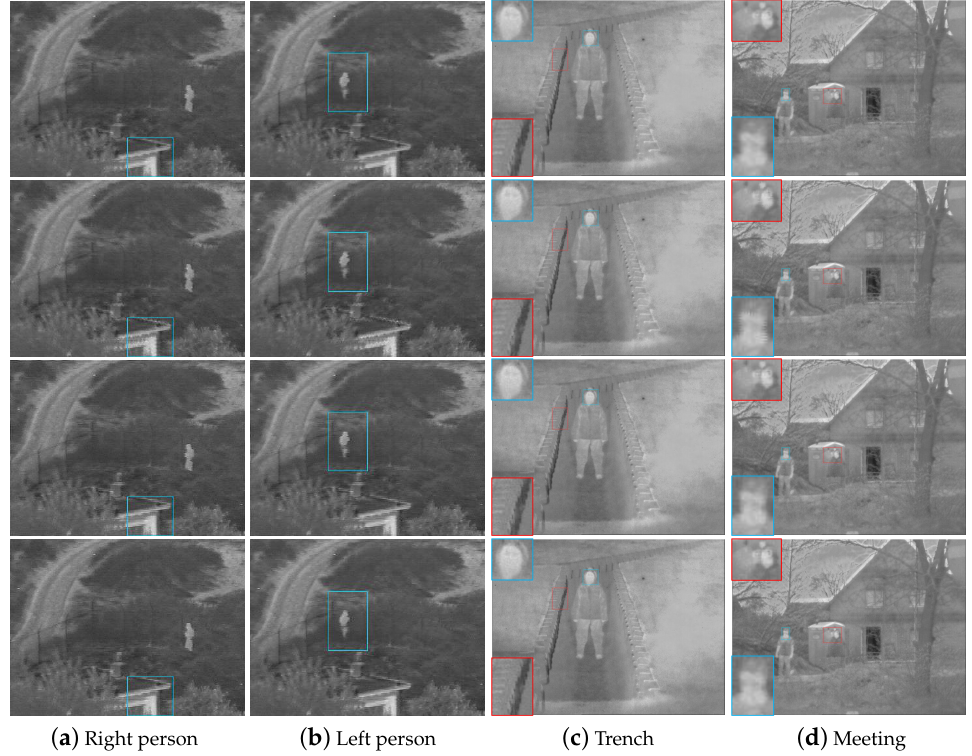
Figure 9. Fusion results on four typical panchromatic VIS and IR images. From top to bottom: Wavelets [17], MSVD [18], CVT [19], and DTCWT